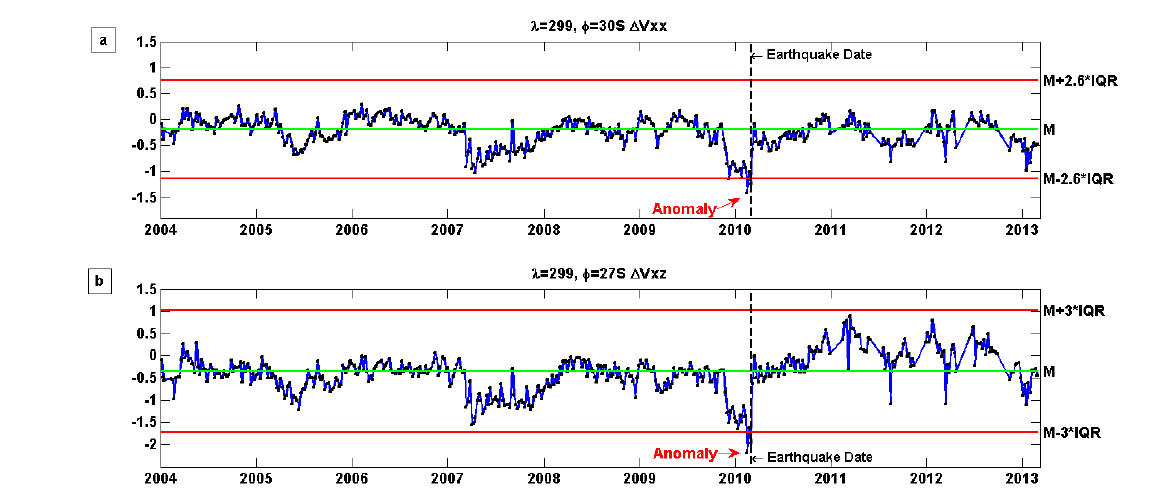
Figure 5. Weekly time series of ∞ V and ∞ V components obtained from GRACE Level 2 data after DDK3 filtering. Seasonal (annual and xx xz semiannual and S2 tidal wave) signals and linear trend are removed from time series using least squares. The black vertical lines indicate the date of the earthquake. The red horizontal lines indicate the upper and lower bounds. The green horizontal lines indicate median values.